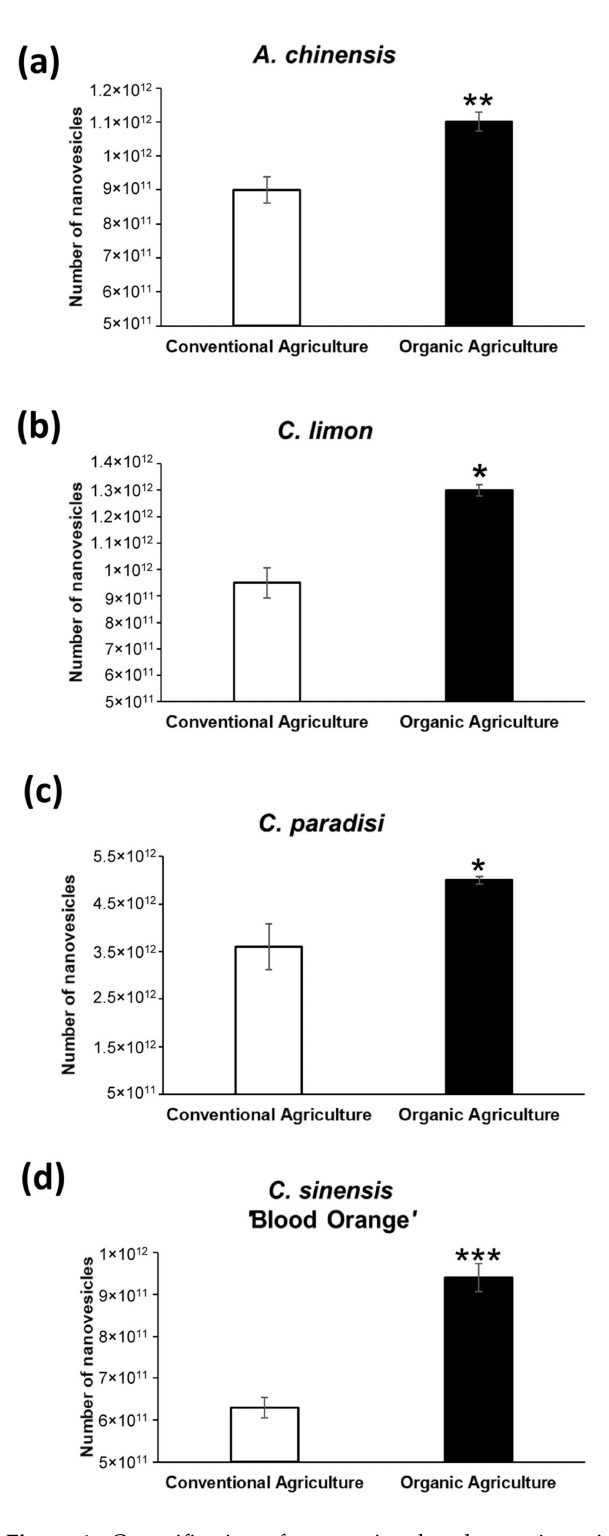
Figure 1. Quantification of conventional and organic agriculture-derived nanovesicles through Nanoparticle Tracking Analysis (NTA): ( a ) quantification of nanovesicles isolated from kiwi ( A. chinensis ); ( b ) quantification of nanovesicles isolated from lemon ( C. limon ); ( c ) quantification of nanovesicles isolated from grapefruit ( C. paradisi ); ( d ) quantification of nanovesicles isolated from blood orange ( C. sinensis ‘Blood Orange’). Data are expressed as the mean ± SE. *: p < 0.05; **: p < 0.001; ***: p <